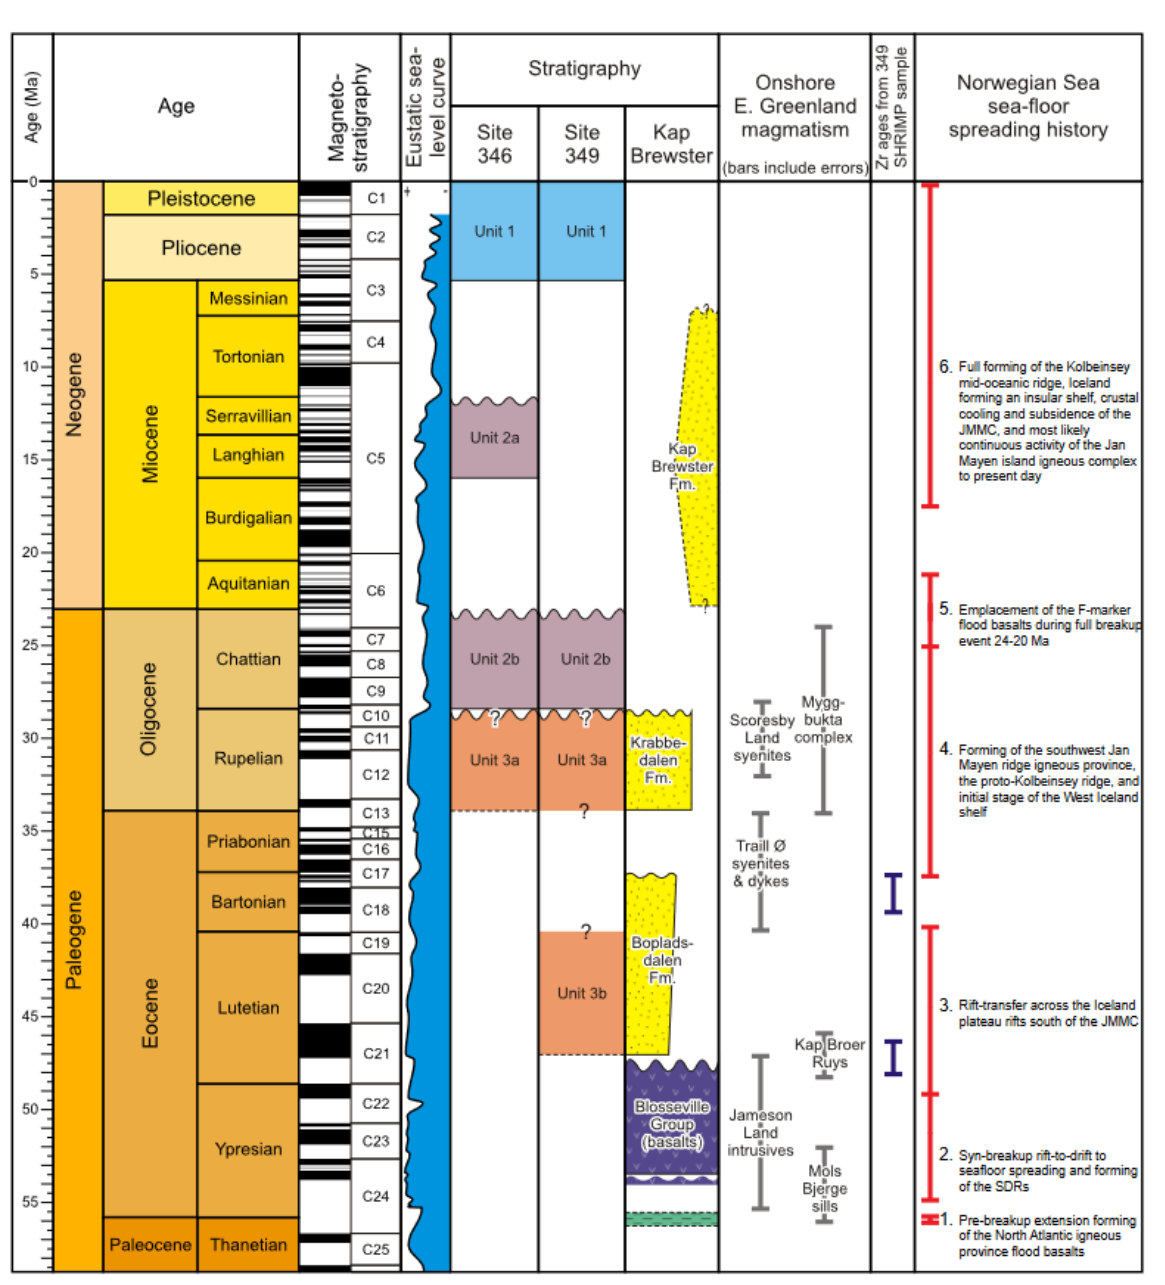
Figure 7. Stratigraphic relationships between Kap Brewster and DSDP sites 346 and 349, compared with igneous events in East Greenland and Greenland-Norway seafloor spreading history. Blosseville Group basalt ages are from Larsen et al. [23] and Storey et al. [24]. East Greenland magmatic events are from Nielsen [25] and Upton et al. [26]. Seafloor spreading history is from Blischke et al.